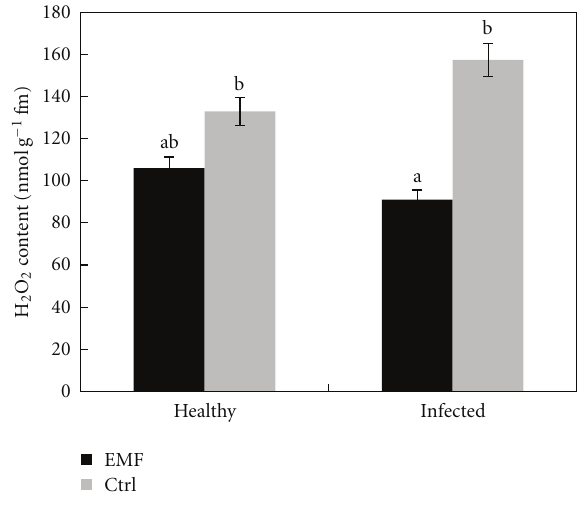
Figure 6: E ff ect of EMF on H 2 O 2 content in healthy and infected plants of Citrus aurantifolia. Vertical bars indicate mean ± SE of three replicates. Di ff erent letters indicate significant di ff erences ( P < 0 .